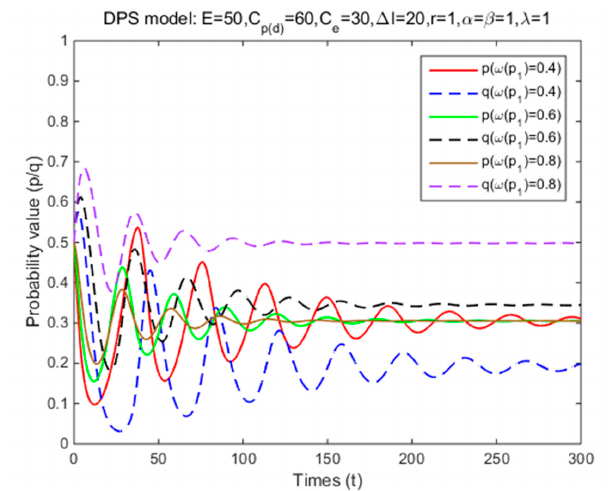
Figure 8. The effects of decision weight on strategy probabilities of cyclists and law enforcement under DPS (Situation 3). DPS (Situation 3). Int. J. Environ. Res. Public Health 2020 , 17 , x